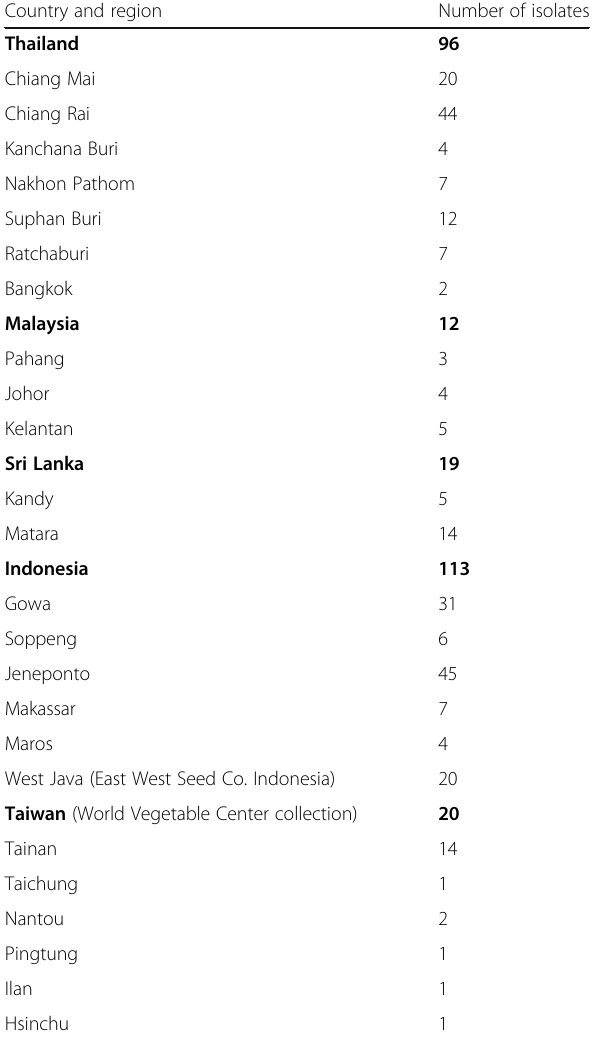
Figures in bold represent the total number of isolates from each